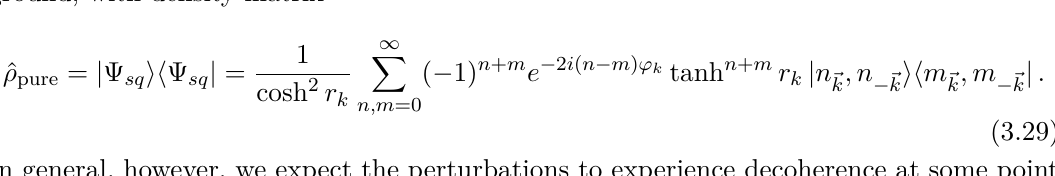
Figure 7. The complexity (3.28) of a pure squeezed cosmological perturbation (3.25) grows while the mode is outside the horizon during de Sitter accelerated expansion, but decreases during radi- ation domination, leading to a period of de-complexification . Once the mode re-enters the horizon, rapid oscillations in e − 2 iφ k lead to rapid oscillations in the complexity. ground, with density